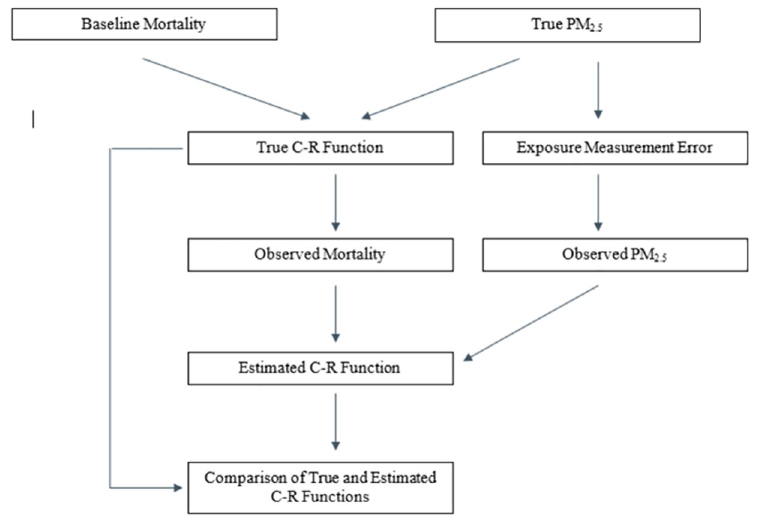
Fig 1. Flow chart of simulation